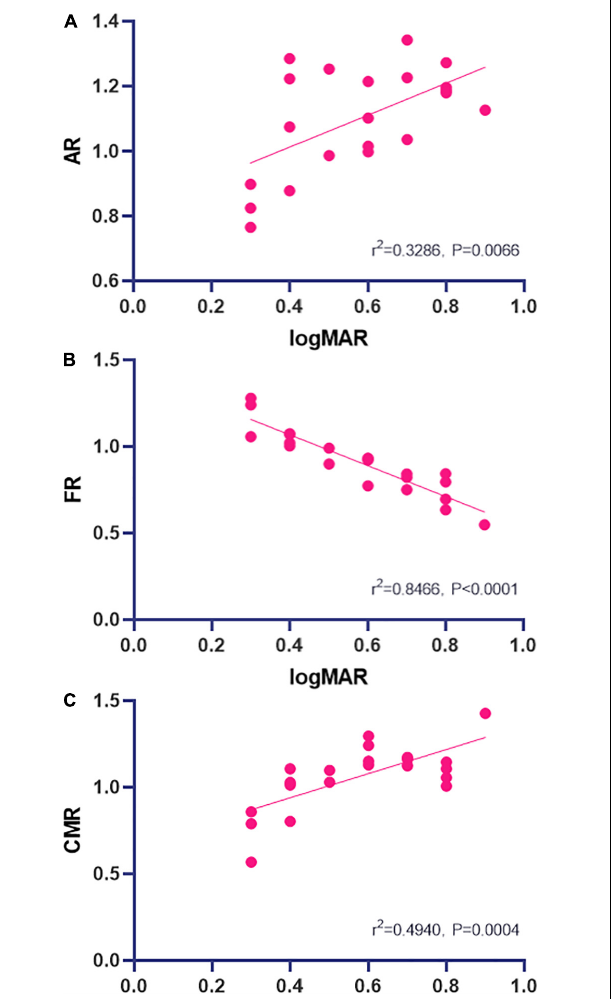
FIGURE 4 | Correlations between mean ALFF signal values and logMAR acuity. The ALFF signal value of AR showed a positive correlation with logMAR [ r 2 = 0.3286, P = 0.0066; (A) ] and the ALFF signal value of FR showed a negative correlation with logMAR [ r 2 = 0.8466, P < 0.0001; (B) ]. The logMAR showed a positive correlation with the ALFF signal value of CMR [ r 2 = 0.4940, P = 0.0004; (C) ] (A lower LogMAR value means better acuity). ALFF, amplitude of low-frequency fluctuation; AR, Angular_R; CMR, Cingulum_Mid_R; FR,